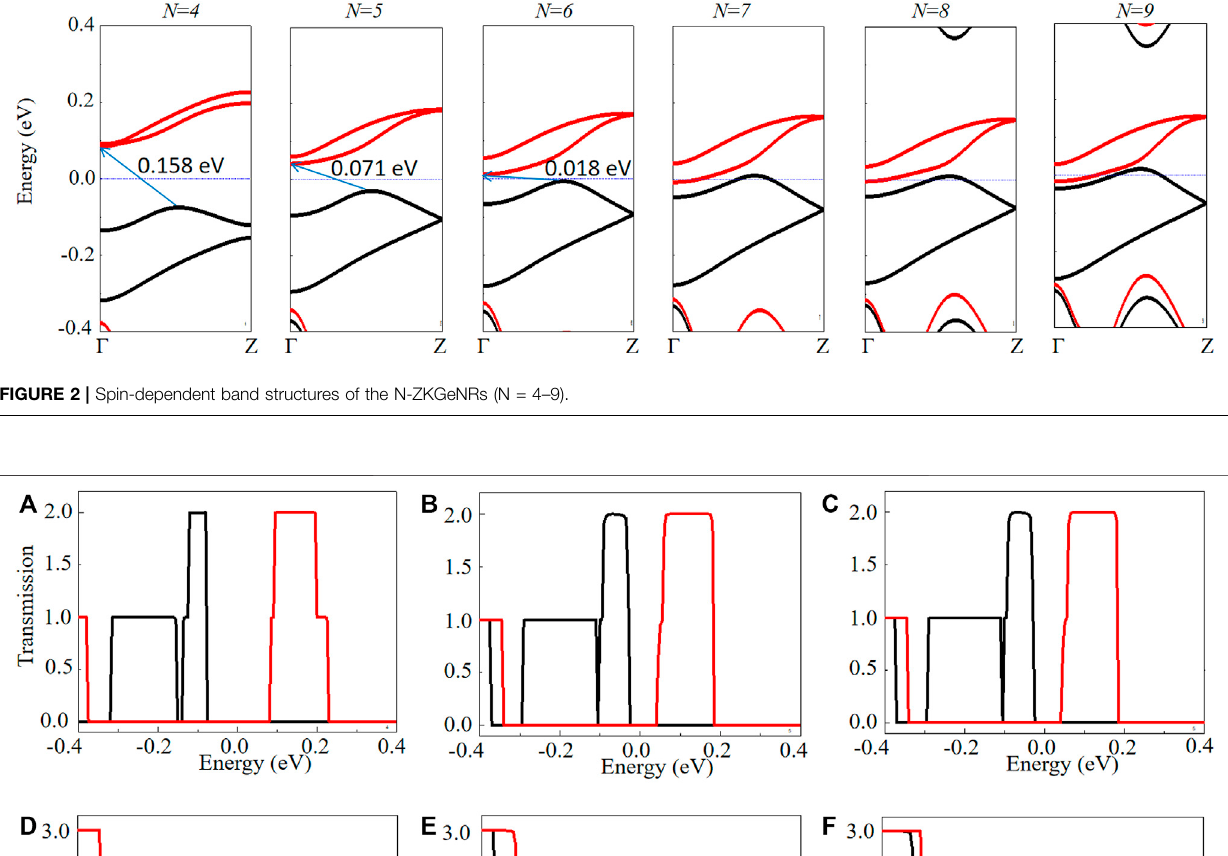
Frontiers in Physics |